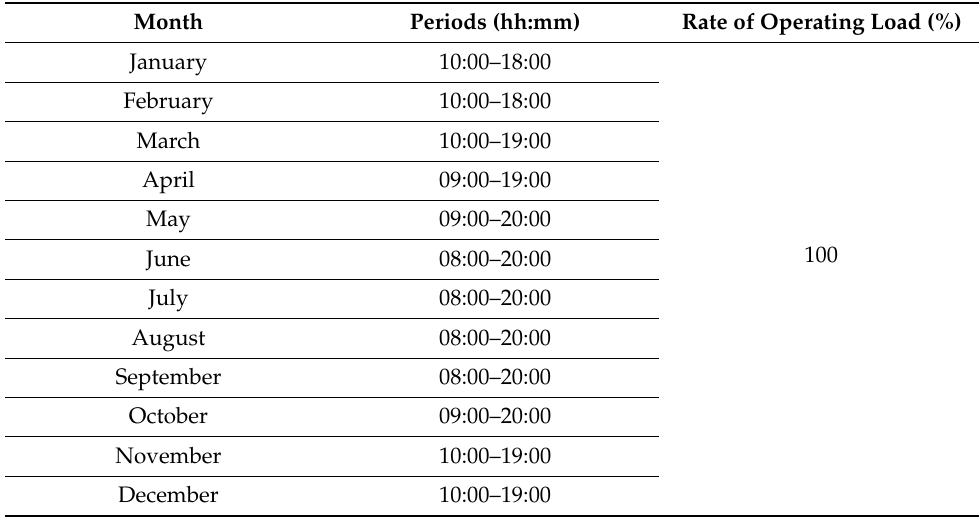
Table 6. Monthly operation schedule for switching on-and-off air conditioner.